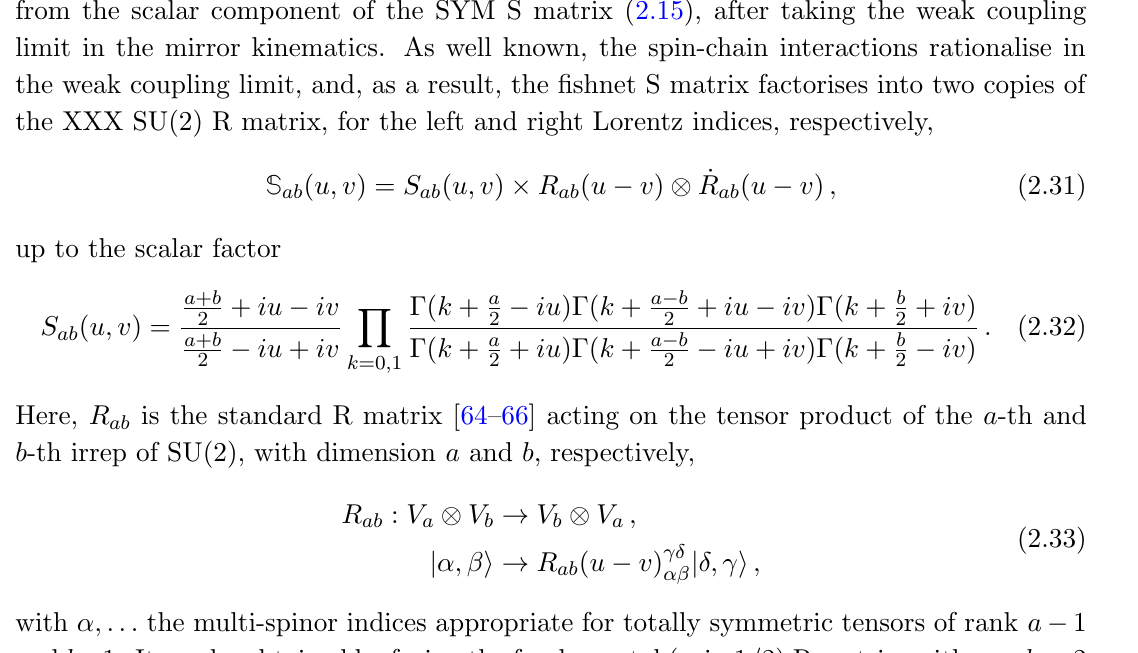
P , and the uw S ! (cid:0) u !